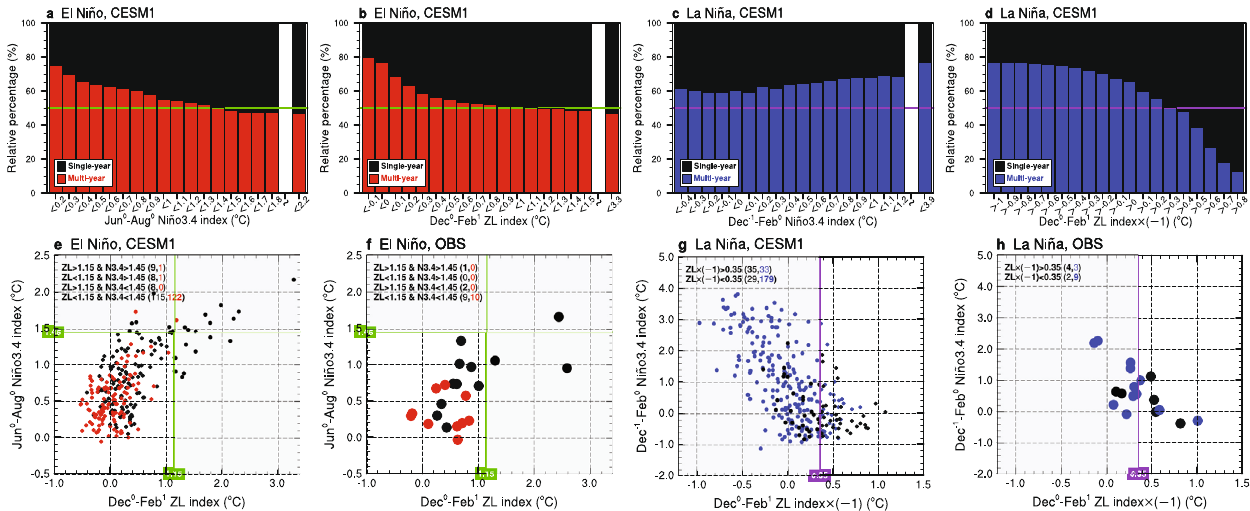
Fig. 4 Thresholds of the identi fi ed key factors and their implication for ENSO prediction. a , b Relative percentages of the single (black bar- chart) and multi (red bar-chart)-year El Niños in the CESM1 with their key factors of developing-season intensity changing from 2.2 to 0.2 °C and zonal maximum location changing from 3.3 to − 0.1 °C. c , d Same as a , b except for single (black bar-chart) and multi (blue bar-chart)-year La Niñas with their key factors of pre-onset Paci fi c condition changing from 3.9 to − 0.4 °C and zonal maximum location changing from − 1.0 to 0.8 °C. The green and purple horizontal lines in a – d mark a 50% relative percentage for identifying thresholds from the key factors. e , f Scatter plots of the zonal maximum location against the developing-season intensity for the single (black dots) and multi (red dots)-year El Niños in the CESM1 and observations. The numbers of single- and multi-year El Niños in the four regimes separated by two thresholds (two green lines) are, respectively, shown as black and red text in the legend with larger numbers in bold. g , h Same as e , f except they display the zonal maximum location against the pre-onset Paci fi c condition for single (black dots) and multi (blue dots)-year La Niñas with the two regimes separated by one threshold (one purple line). Gray shadings in e – h indicate regimes where the major ENSO group (single-year event for El Niño or multi-year event for La Niña) is